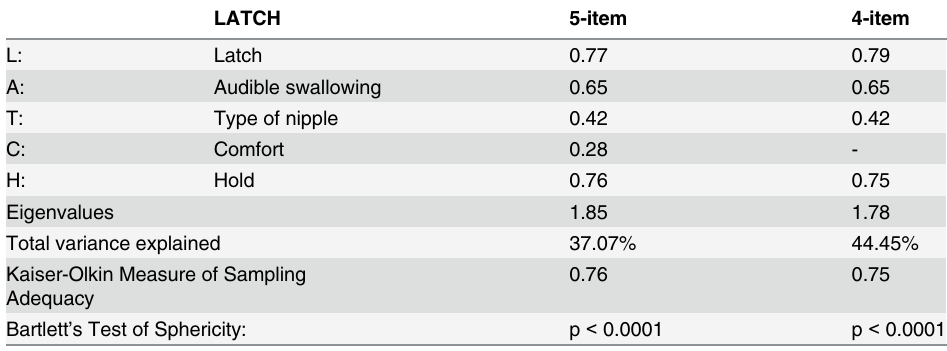
Table 1. Exploratory factor analysis of the 5- and 4-item LATCH breastfeeding assessment tools using principal axis factoring extraction method among vaginally delivered women (n = 334). LATCH 5-item